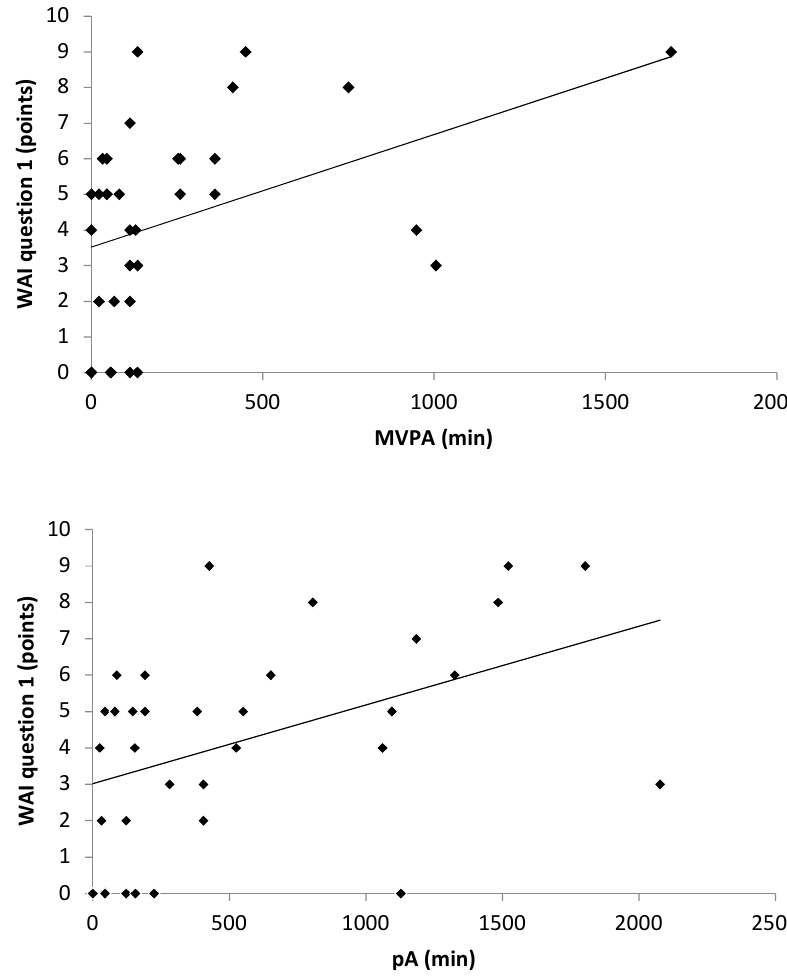
Figure 3. Scatter diagrams between self-perceived work ability (WAI question 1), physical activity (pA) and MVPA of the past seven days with regression lines. WAI work ability index, pA physical activity, MVPA moderate to vigorous physical activity.